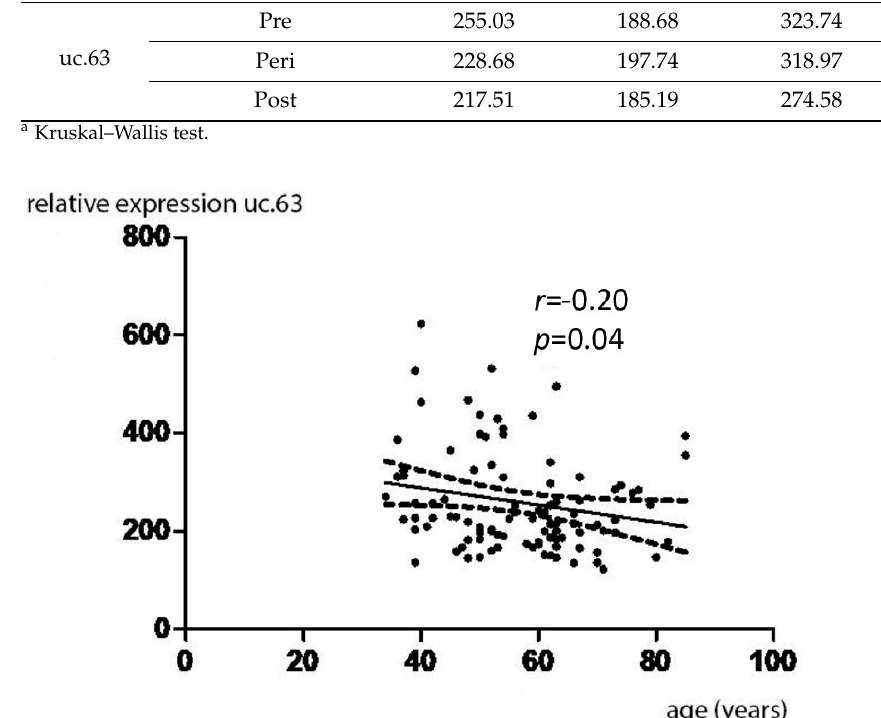
Figure 1. Expression of uc.63 in patients with breast carcinoma in relation to the age.